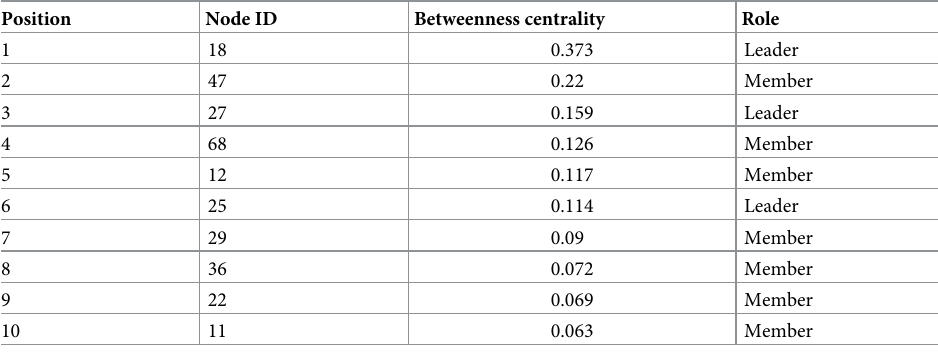
Table 2. Betweenness centrality values and role (Meetings network). Position Node ID Betweenness